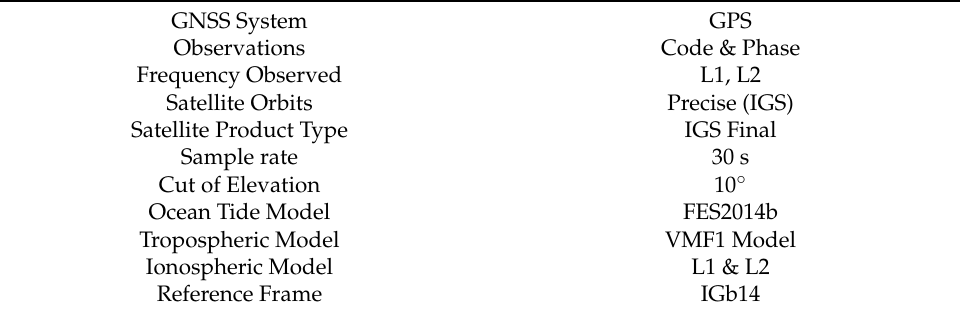
Table 2. CSRS-PPP Service’s processing parameter